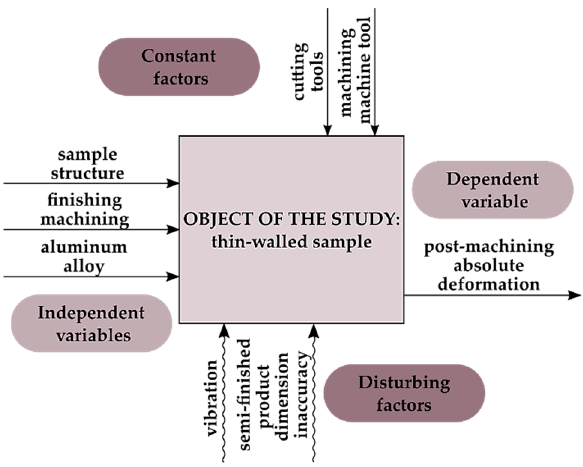
Figure 1. Study object model.